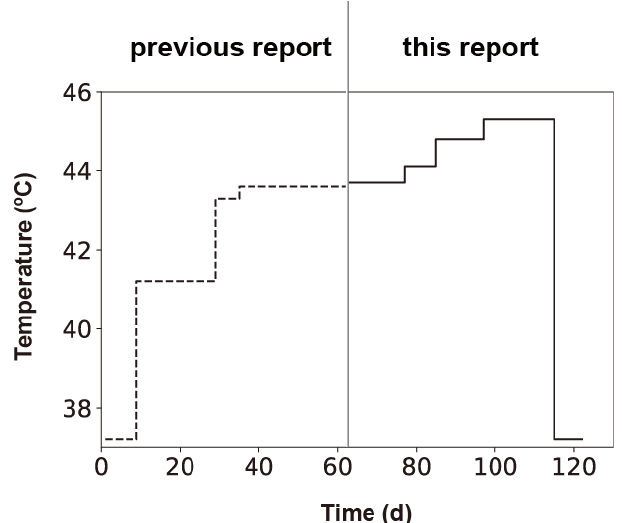
Figure 1. Thermal profile of the adaptation experiments. Thermal adaptation was initiated at 37.2 °C; culture temperatures were increased in a stepwise manner to 45.3 °C. After adaptation to 45.3 °C, populations were then returned to 37.2 °C to investigate whether Qβ can revert to its ancestral sequence. The adaptation process for temperatures ranging from 37.2 to 43.6 °C has been described previously [7].